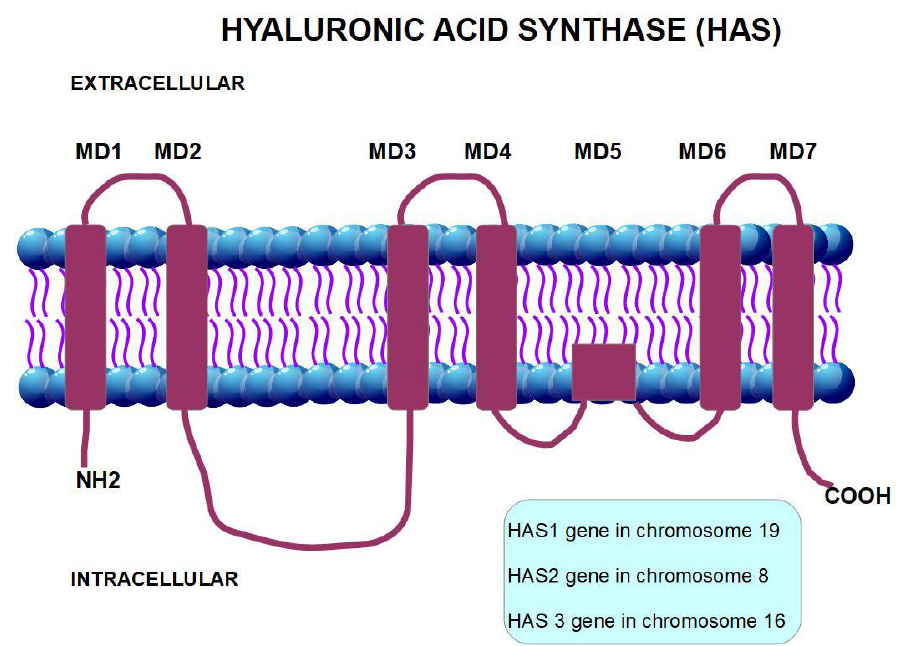
Figure 3. Structural representation of HAS2.